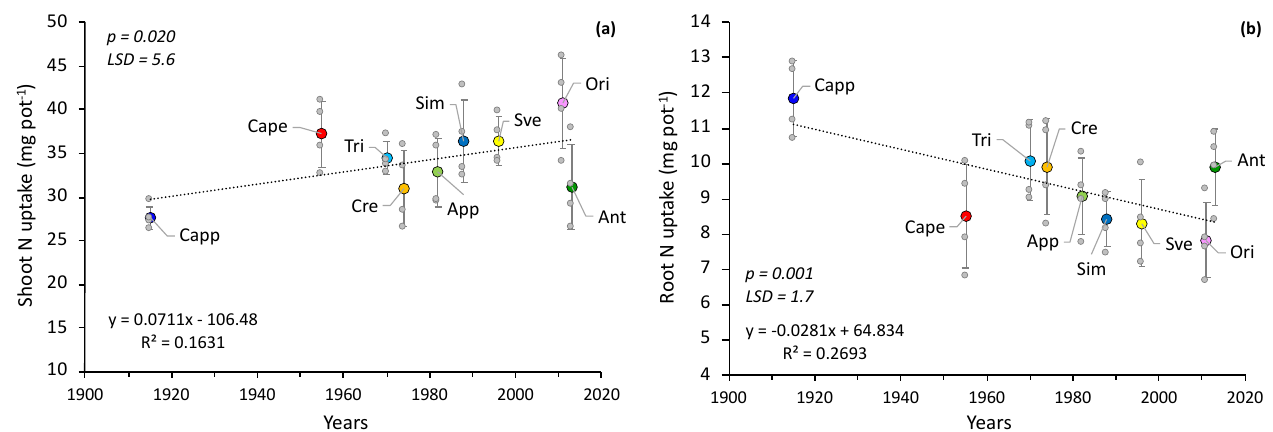
Figure 1. Relationships between shoot N uptake ( a ) and root N uptake ( b ) and the year of release of the nine studied genotypes at 90 days after emergence (Time 1). For each trait the p value and the LSD (Fisher’s LSD test, p = 0.05) are reported. All genotype data are plotted with the mean depicted as a colored circle ± standard deviation ( n = 4) represented by the end of the vertical black line. N, nitrogen; LSD, least significant difference.